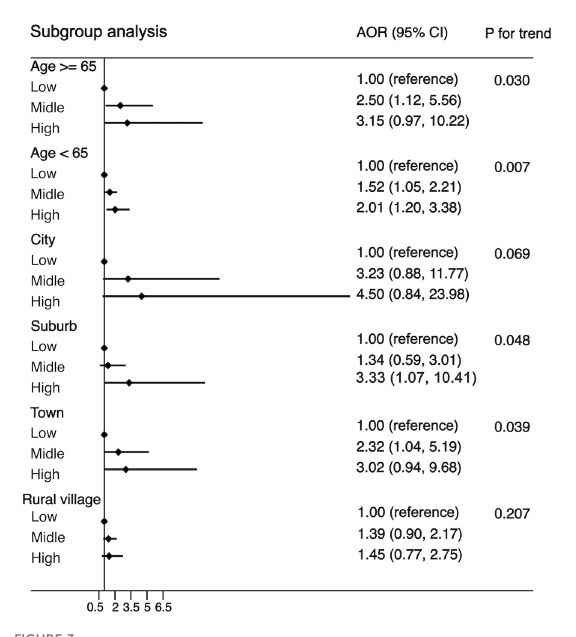
FIGURE 3 Strati fi cation analysis of the association between WBC and risk of MS. Subgroups based on age (age <65 years, age ≥ 65 years) or residence (city, suburb, town or rural village). Data are shown as OR and 95%